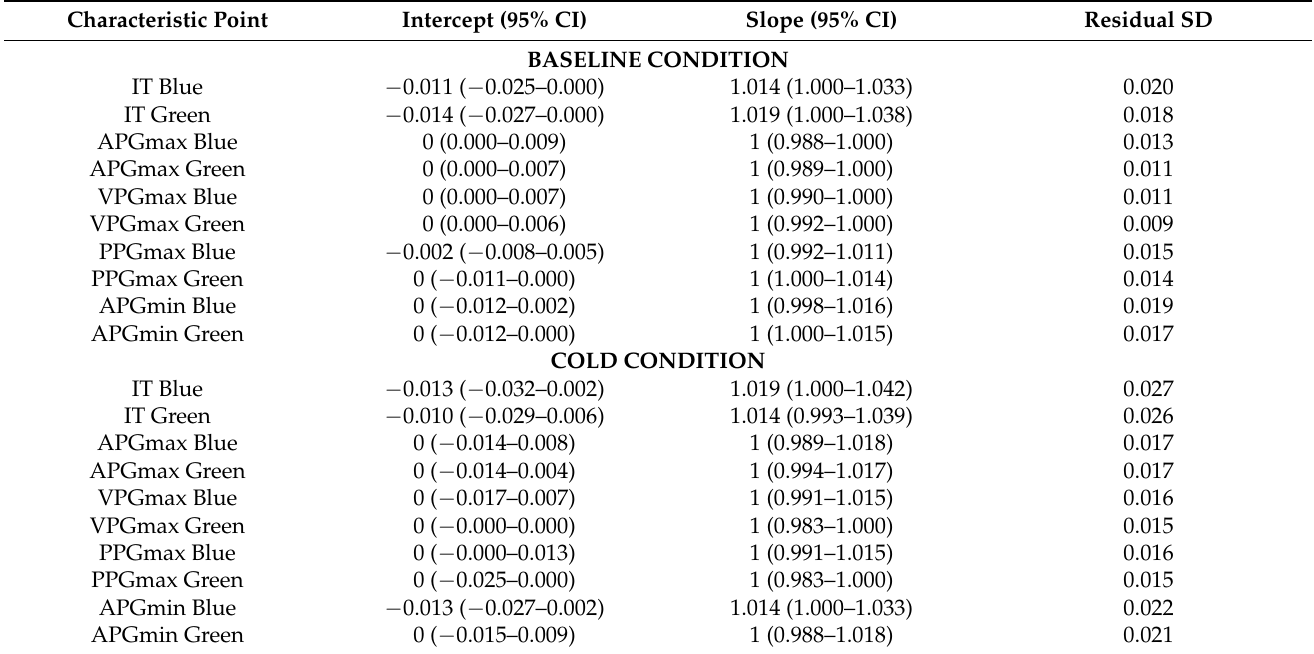
Table 2. Results of Passing-Bablok regression analysis of 720 ECG-PPG data pairs from 12